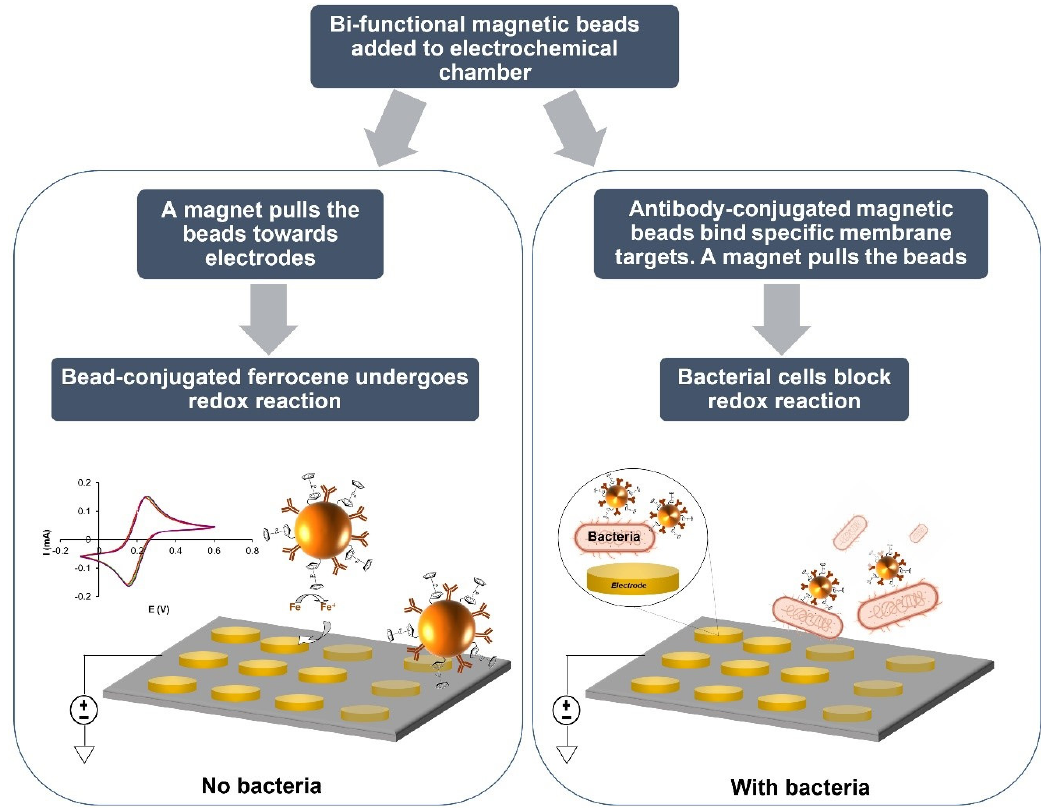
Figure 1. Dual-mode bioelectrochemical sensor. The measurement chamber includes a micro-fabricated electrochemical cell array (containing working, reference and auxiliary electrodes) and is equipped with a magnet. Bi-functional MNP (tagged with specific antibodies and electroactive markers, such as ferrocene) are added to the sample. Upon activation of the magnet, particles are pulled towards the electrode allowing the voltammetric detection of the ferrocene marker. In the presence of bacteria; however, antibody-labeled MNP strongly bind to membrane antigens, resulting in a decrease in the measured current response.